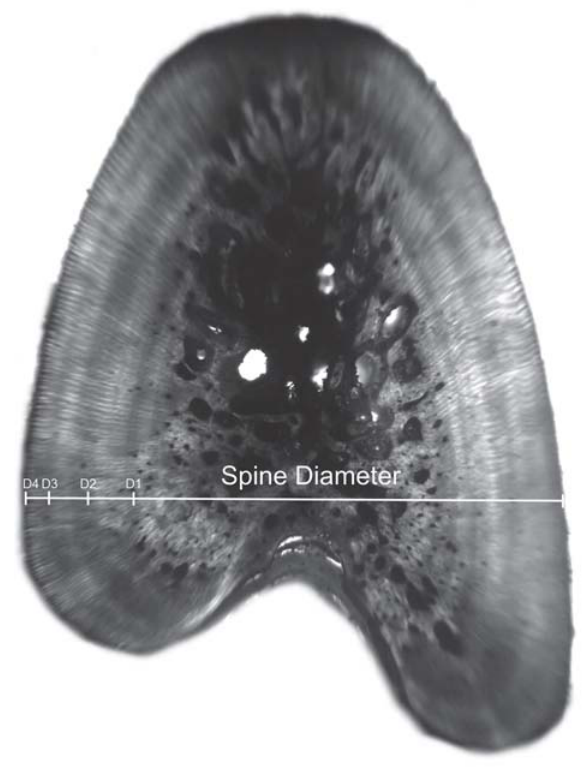
Fig. 2. Cross-section of first dorsal spine of T. obesus (128 cm) showing the spine and band